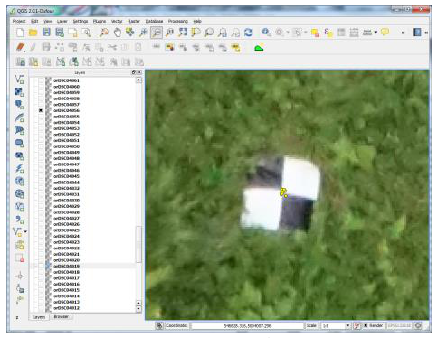
Figure 10: Distribution of